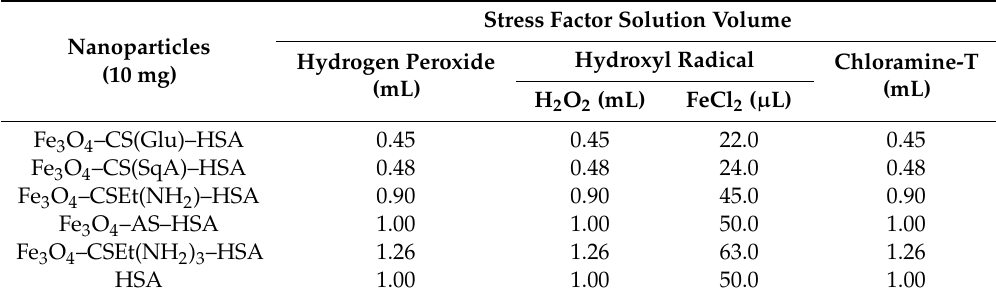
Table 1. Volume of stress factor solutions used per 10 mg of nanoparticles. Solution